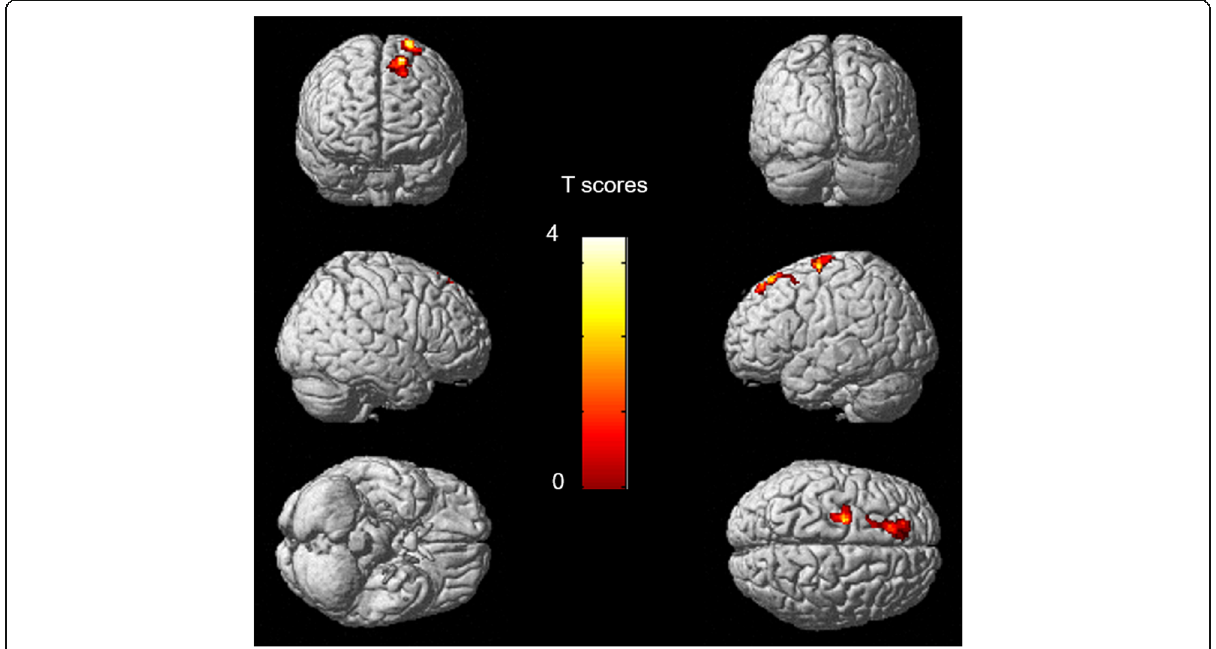
Fig. 3 Anatomical localization of areas of increased metabolism in patients with acrophobia after VRET ( p < 0.005, k > 178), projected onto 3D volume rendering. After VRET, patients showed increased metabolism in left superior frontal gyri (BA6-8) and in the left precentral gyrus (BA8). L : left, R : right